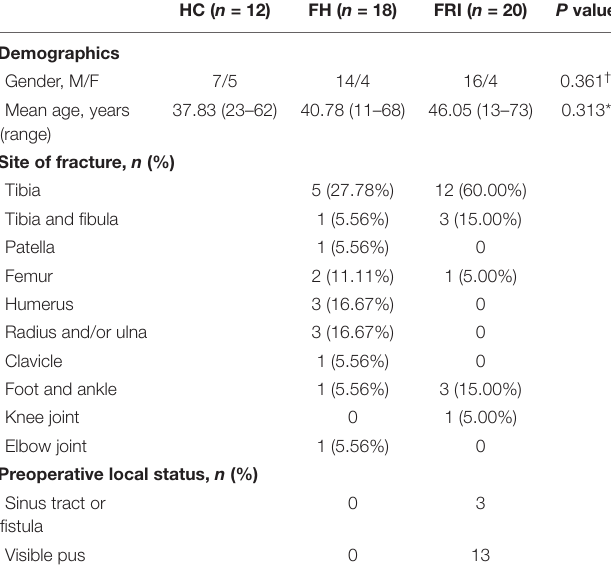
TABLE 1 | Clinical characteristics of the included